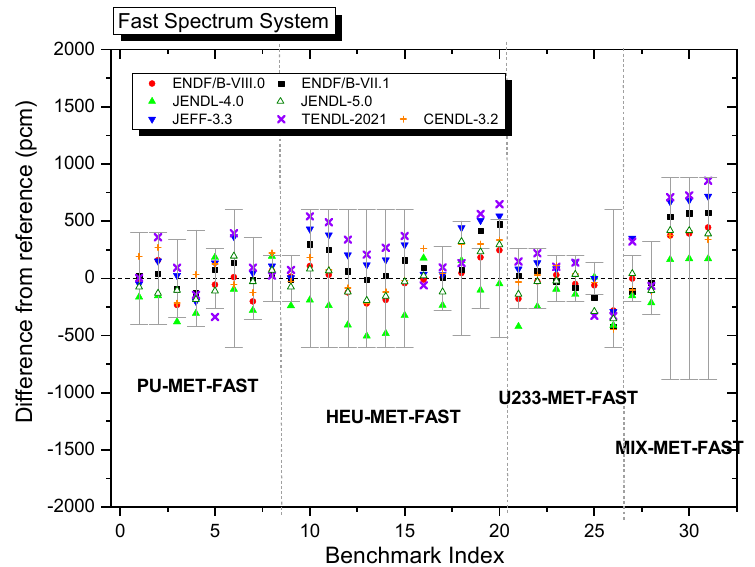
Figure 4. The difference between calculated and experimental k eff by ENDL for the ICSBEP fast benchmarks.